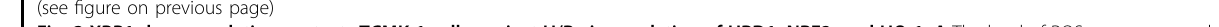
Fig. 3 XBP1 downregulation protects TCMK-1 cells against H/R via regulation of HRD1, NRF2, and HO-1. A The level of ROS was attenuated by lenti-shRNA- Xbp1 transduction in H/R-exposed TCMK-1 cells. DCFH-DA assay; ** P < 0.01 vs. lenti-control H/R group at each time point ( n = 6). B P53, ATM, and cleavage caspase 3 expression were ascended by lenti- Xbp1 transduction and descended by lenti-shRNA- Xbp1 transduction in H/R- exposed TCMK-1 cells. Western blot; ** P < 0.01 vs. lenti-control H/R group ( n = 6). C The apoptotic proportion of H/R-exposed TCMK-1 cells was decreased by lenti-shRNA- Xbp1 transduction, as revealed by fl ow cytometry. ** P < 0.01 vs. lenti-control H/R group at each time point ( n = 6). D The BrdU incorporation (proliferative capability) of H/R-exposed TCMK-1 was enhanced by lenti-shRNA- Xbp1 transduction. * P < 0.05 vs. lenti-control H/R group at each time point ( n = 6). E HO-1 expression was negatively modulated by XBP1 expression following lenti- Xbp1 and lenti-shRNA- Xbp1 transduction. Western blot; ** P < 0.01 vs. lenti-control H/R group ( n = 6). F XBP1 positively and negatively regulated HRD1 a n d NR F 2, respectively. * P < 0.05, ** P < 0.01 vs. lenti-control H/R group ( n =